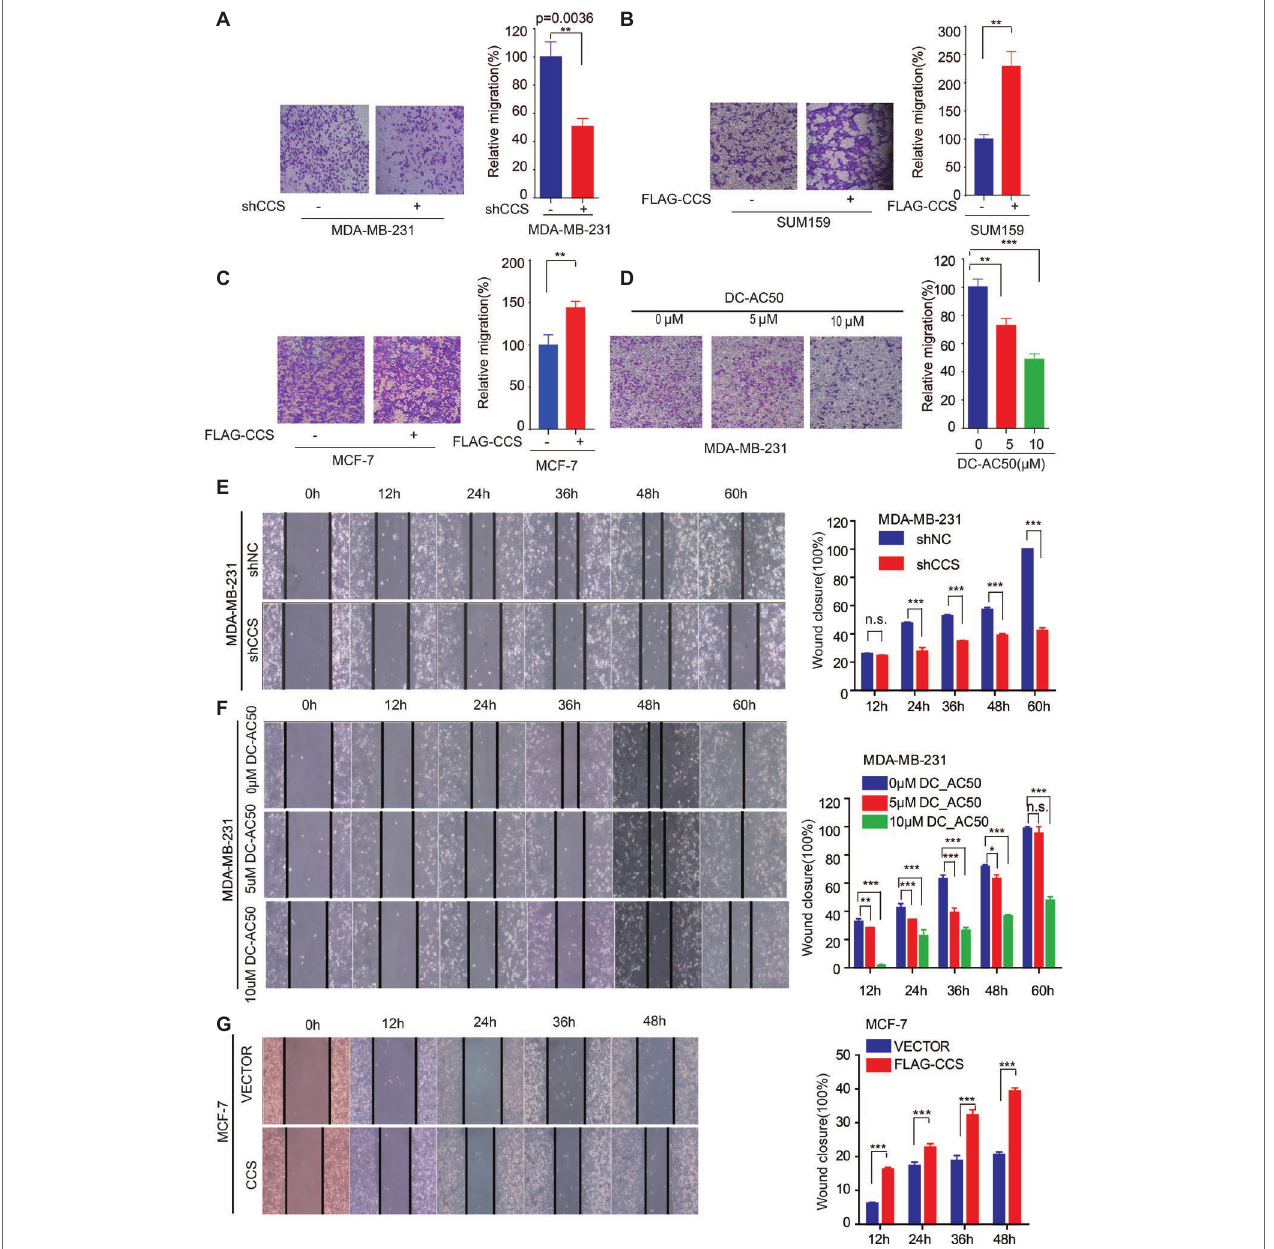
FIGURE 3 | CCS promotes breast cancer cell migration. (A) Cell migration in CCS knockdown and control MDA-MB-231 cells was determined by transwell migration assay (Boyden chamber assay). (B) Cell migration in CCS overexpressing and control SUM159 cells was determined by transwell migration assay. (C) Cell migration in CCS overexpressing and control MCF-7 cells was determined by transwell migration assay. (D) Cell migration in CCS overexpressing and control MDA-MB-231 cells with increasing concentrations of DC_AC50 was determined by transwell migration assay. (E) Cell migration in CCS knockdown and control MDA-MB-231 cells was also determined by wound healing assay. (F) Cell migration in MDA-MB-231 cells treated with increasing concentrations of DC_AC50 was determined by wound healing assay. (G) Cell migration in CCS overexpressing and control MCF-7 cells was determined by the wound healing assay. The modified migration assay was evaluated by calculating the ratio of the cell numbers through the chamber or wound closure after the wound healing assay. All results performed above are presented as mean ± SD from three independent experiments. * p < 0.05; ** p < 0.01; *** p < 0.001, ns: not